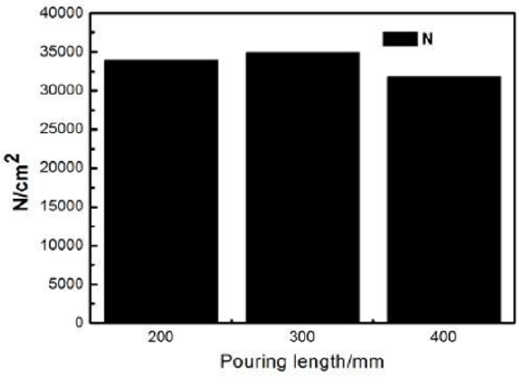
Figure 9. Relationship between number of primary α-Cu phase per unit area and pouring length in semi-solid ZCuSn10P1 alloy.